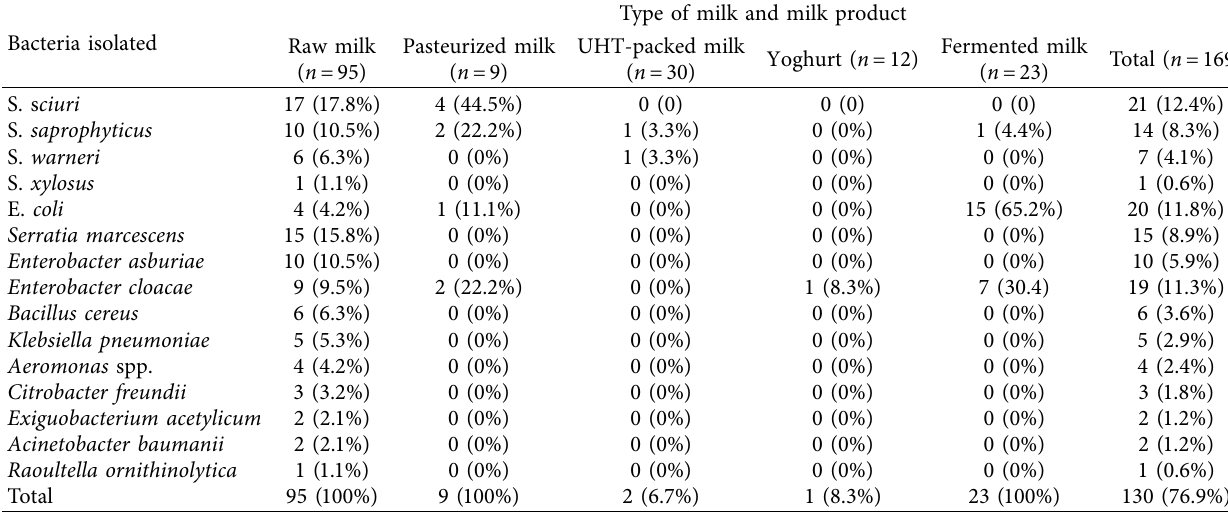
Table 2: Prevalence of various bacteria isolated from milk and milk products sold in various outlets in Juja Sub-County, Kenya. Bacteria isolated